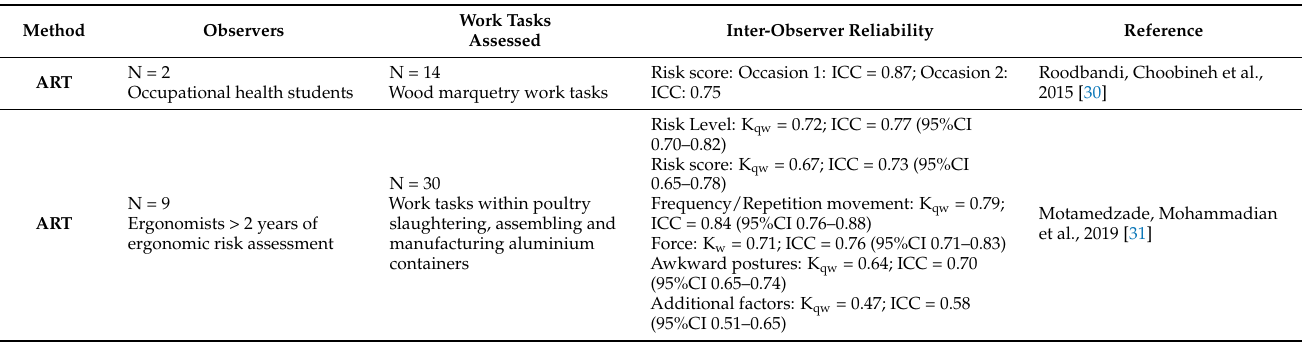
Table A1. Examples of studies that has assessed the inter-observer reliability of one of five risk assessment methods included in the study; Assessment of repetitive tasks of the upper limbs (ART); Hand Arm Risk Assessment Method (HARM); Occupational Repetitive Actions of the Upper